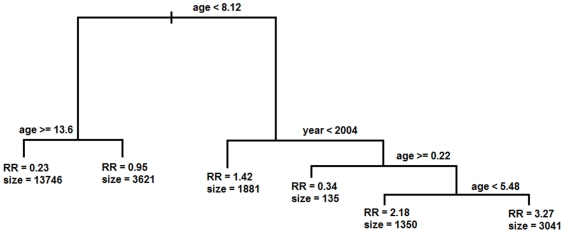
Decision tree generated by Classification and Regression Tree (CART) analysis of risk factors determining the occurrence of P. falciparum malaria attacks (PFA) per trimester.Figure shows the cut-off values identified by CART that divide the dataset into two. At each leaf are given the Relative Risk (RR) and the number of events associated with that leaf.